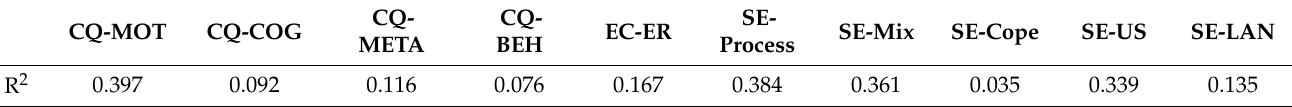
Table 5. Explained variance in endogenous variables of Model